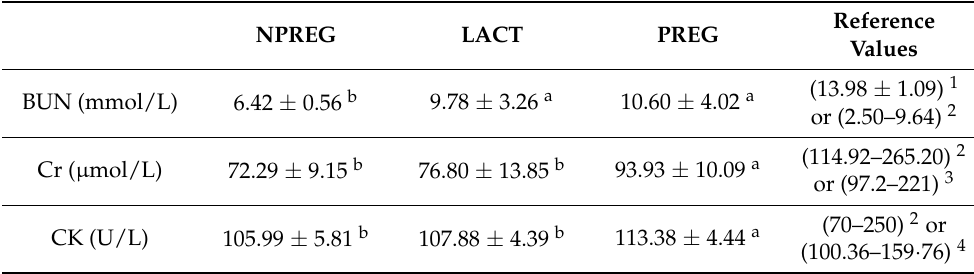
Table 5. Mean values (M ± SD) of, BUN, Cr and CK in non-pregnant non-lactating ( n = 14), non- pregnant lactating ( n = 8) and pregnant ( n = 38) she-camels.